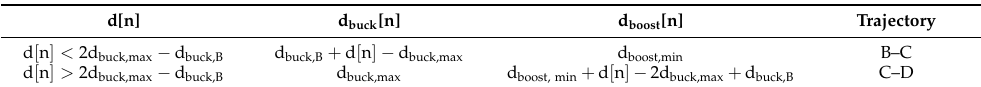
Table 3. Definition of (d buck [n],d boost [n]) pairs to go from B to D as a function of d[n] using the proposed simplifications. Note that all the expressions are in function of d[n], d buck,max , and d boost,min (d buck,B = d buck,max · (1 − d boost,min